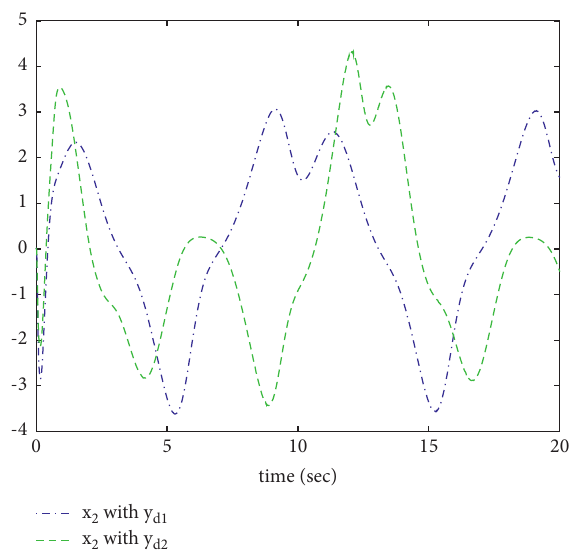
Figure 9: The state variables x